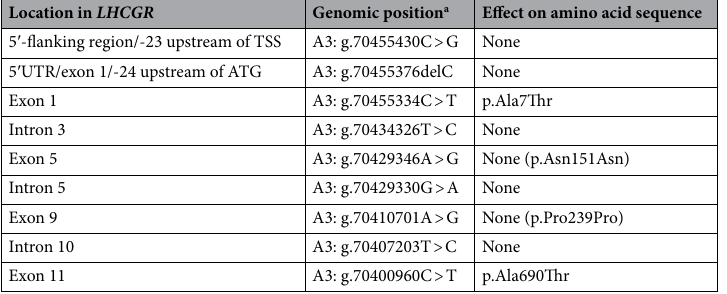
Table 3. Polymorphism detected in the feline LHCGR gene. a Positions in the LHCGR gene according to Felis_ catus_9.0 chromosome A3 (NC_018725.3) reference sequence.